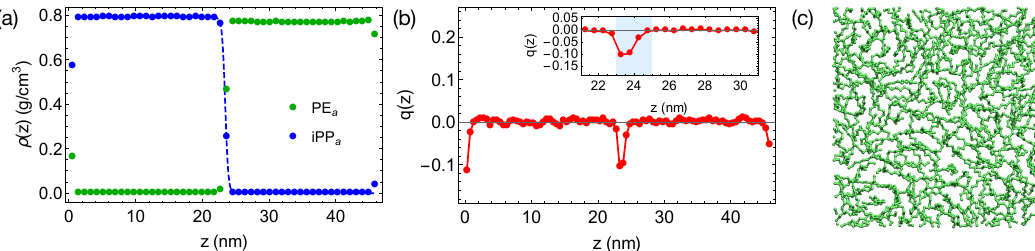
Figure 4. ( a ) Density profiles; ( b ) distribution of nematic order in the PE a /iPP a blend. Dashed curve in ( a ) is a fit to HT theory [47]. Blue region in the inset of ( b ) demonstrates an orientationally ordered region near a planar interface in the PE a domain; ( c ) a snapshot of chain segments in the orientationally ordered